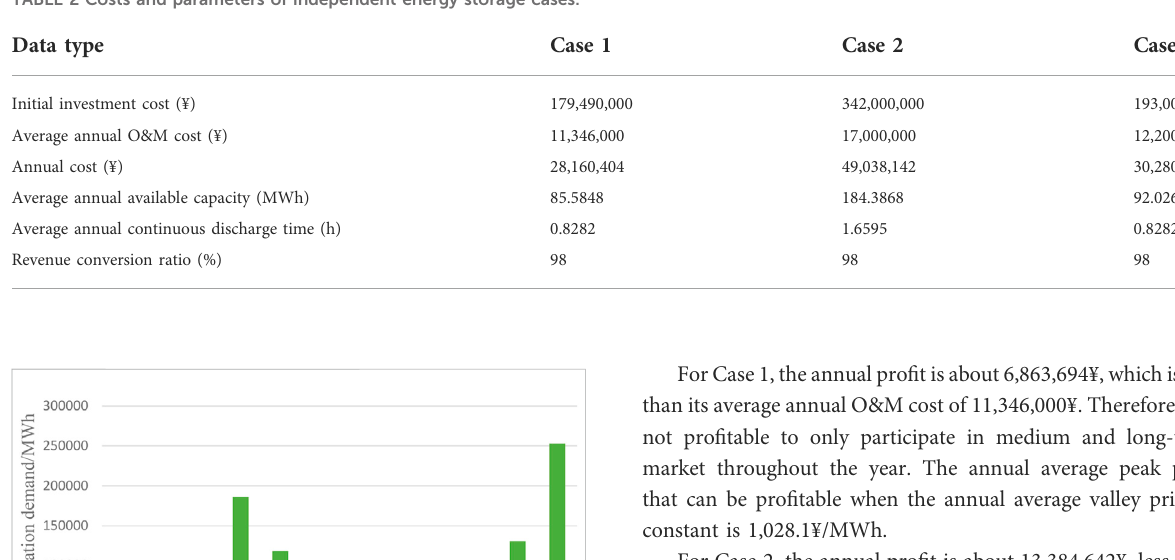
TABLE 2 Costs and parameters of independent energy storage cases.